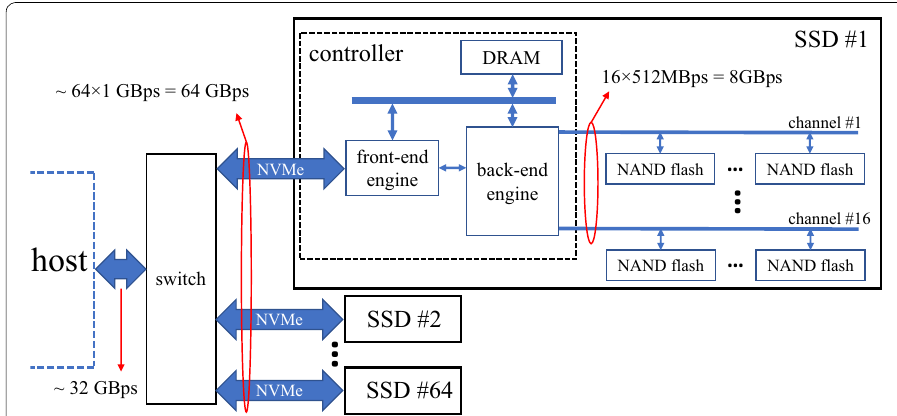
Fig. 2 Modern SSD architecture and data transfer